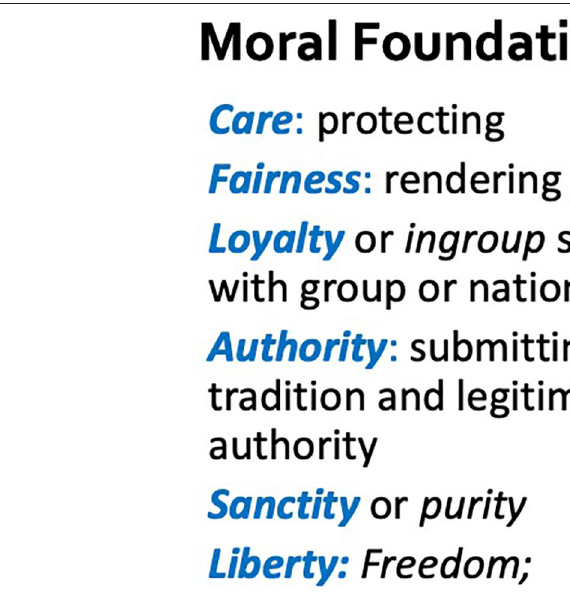
Frontiers in Communication |